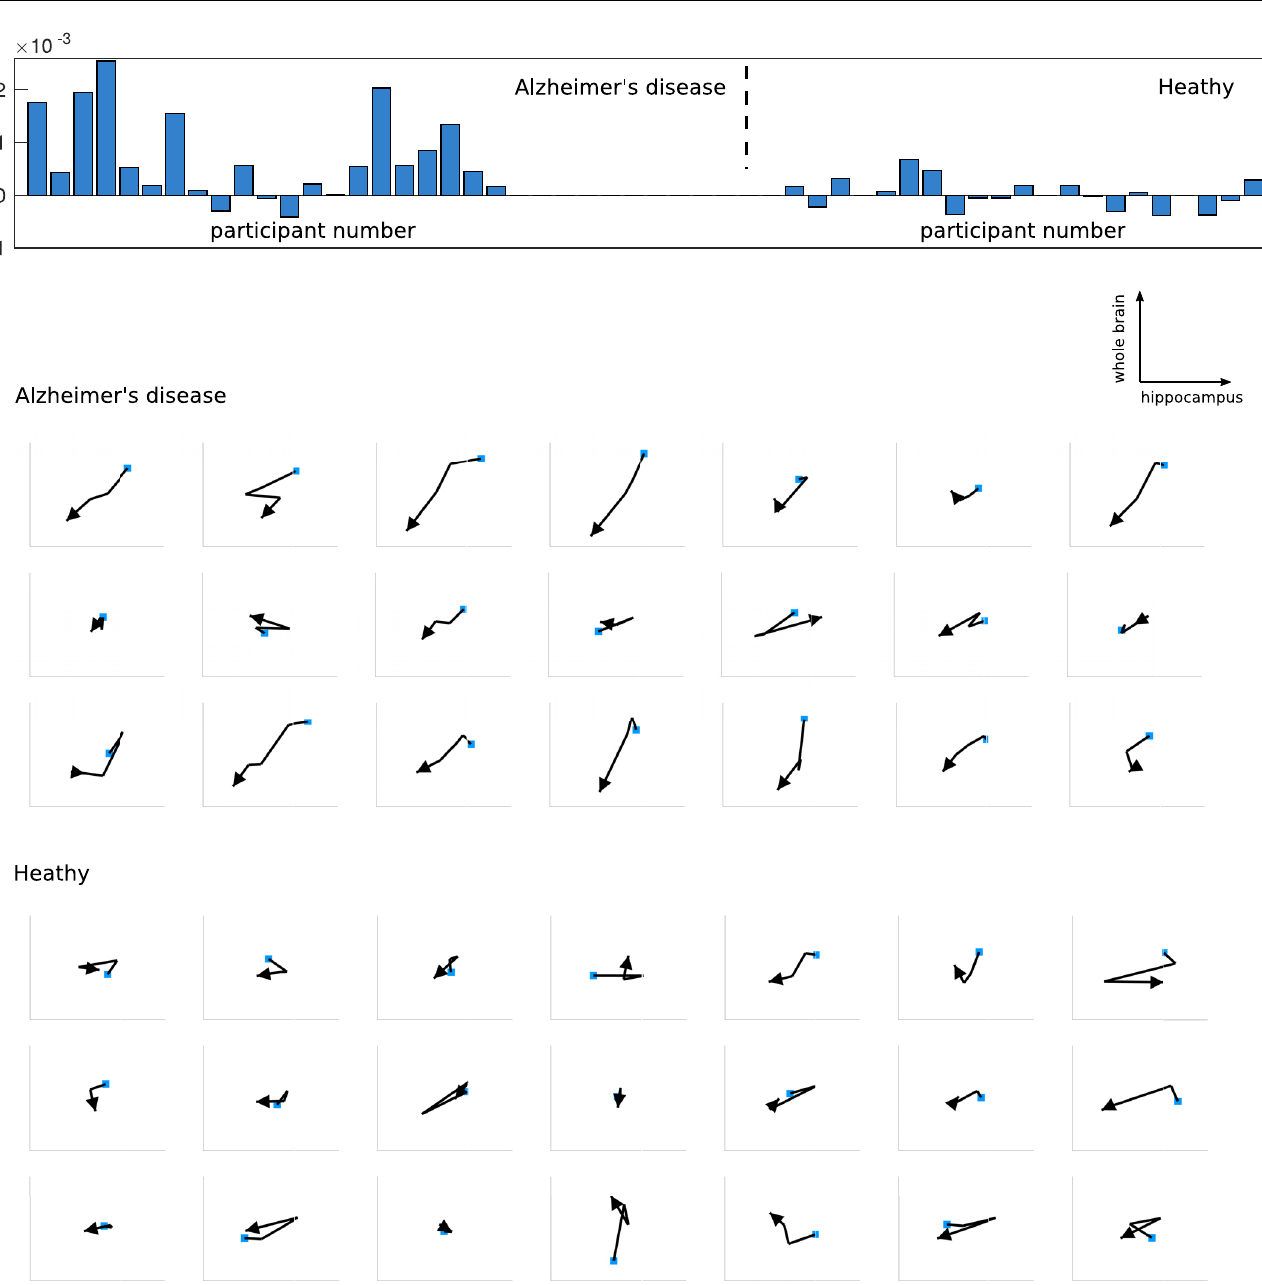
Fig 7. Area terms for the two sets of participants, Alzheimer’s disease and those who remain healthy, with their corresponding paths. The bar chart at the top shows the value of the area (Hippocampus, Wholebrain) path signature term for each set. The graphs show the corresponding paths for each participant in the same order as in the bar chart. The paths are in the scaled hippocampus vs . wholebrain space and ordered in time, with the first observation shown by a blue square and the final observation shown by an arrow. Paths directed towards the north-east or south-west generate positive areas; those towards the north-west or south-east correspond to negative areas. The set of participants with Alzheimer’s disease shows a consistent south-west direction in the trajectory; the healthy set has participants with both positive and negative area terms and shows no general trend in the path